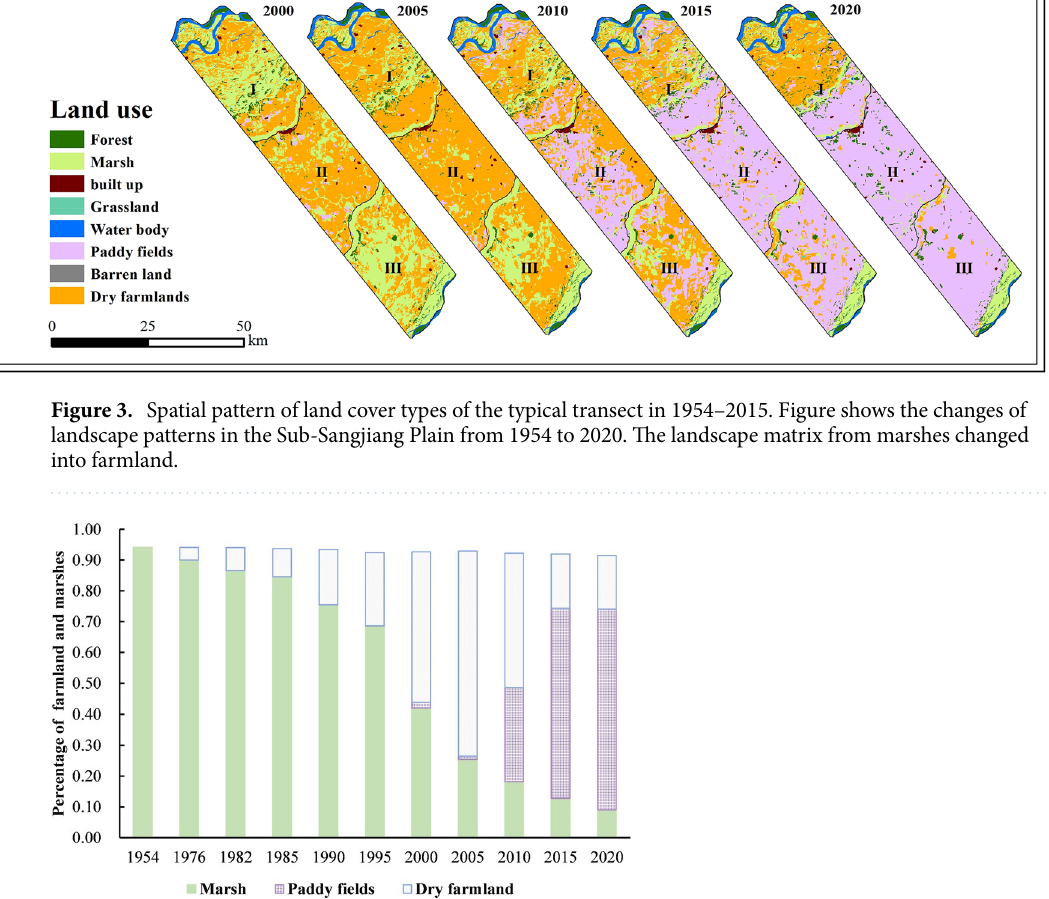
Figure 4. Composition ratio of main land cover types of the typical transect in 1954–2020. Figure shows the percentage of paddy fields, dry farmland and marshes in sub-Sangjiang Plain. And the change of them